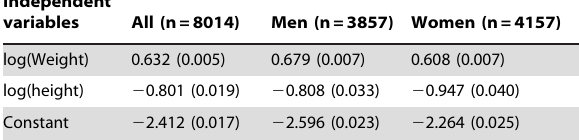
Table 3. Coefficients (standard errors) of regressing log waist circumference (meter) upon log weight (kg) and log height (meter).